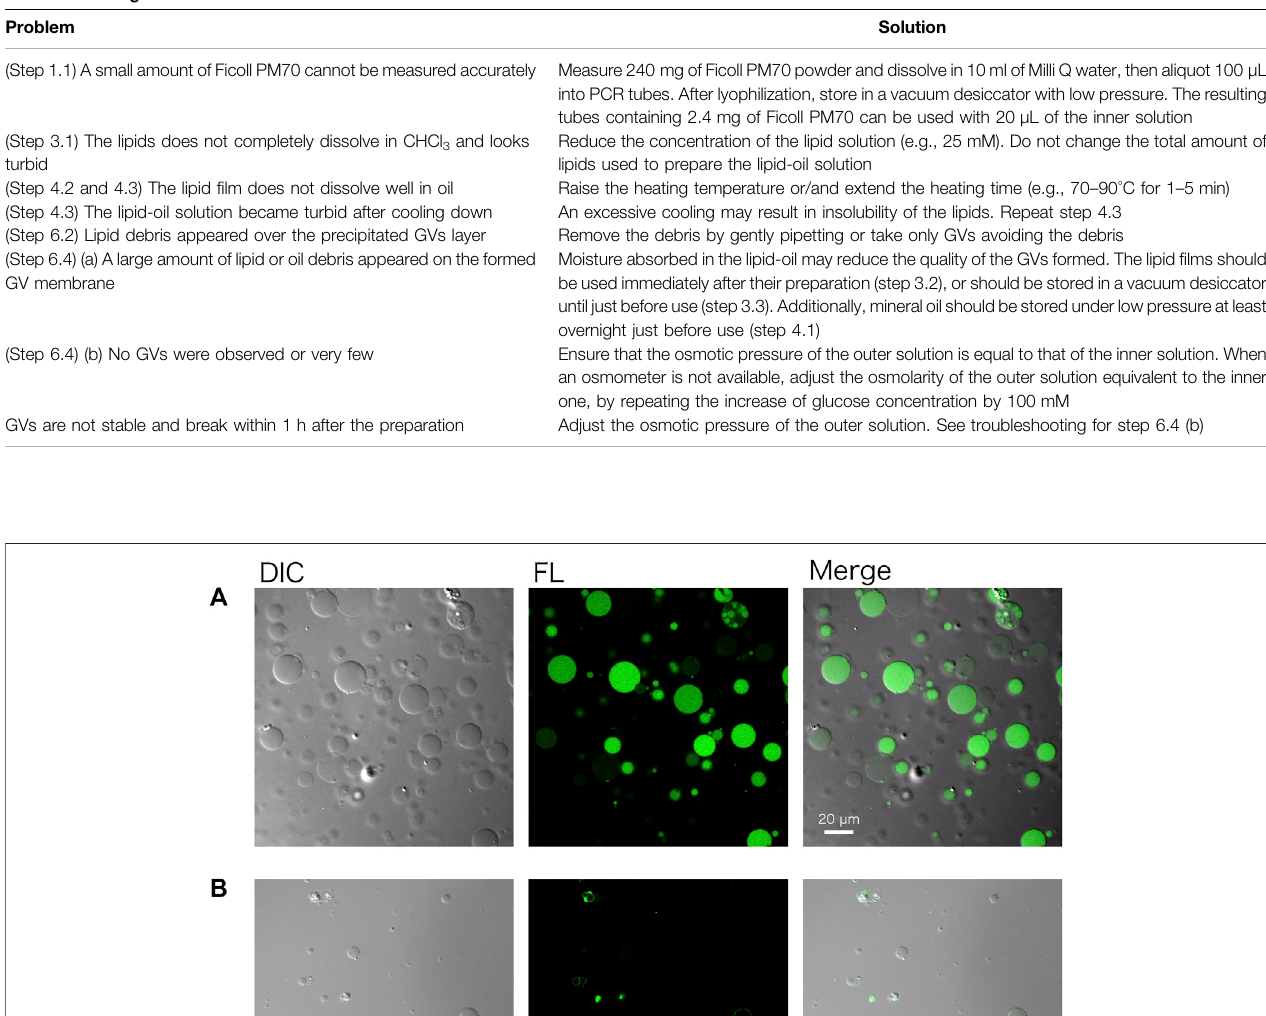
Frontiers in Bioengineering and Biotechnology |